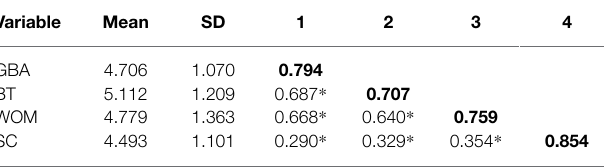
TABLE 3 | Descriptive statistics and bivariate